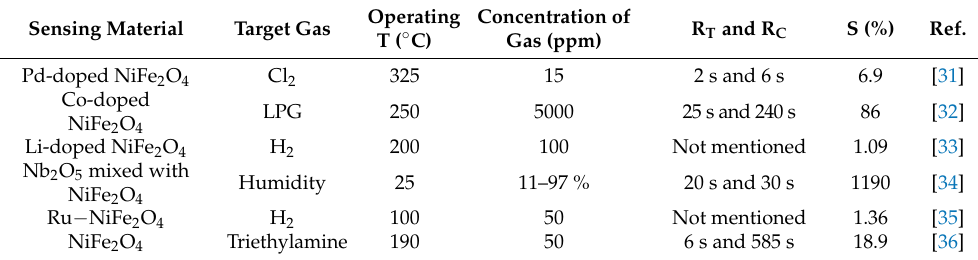
Figure 2. Schematic diagram of metal oxide sensing mechanism [30]. Table 1. Reports of efficient gas-sensing performance of nickel ferrite